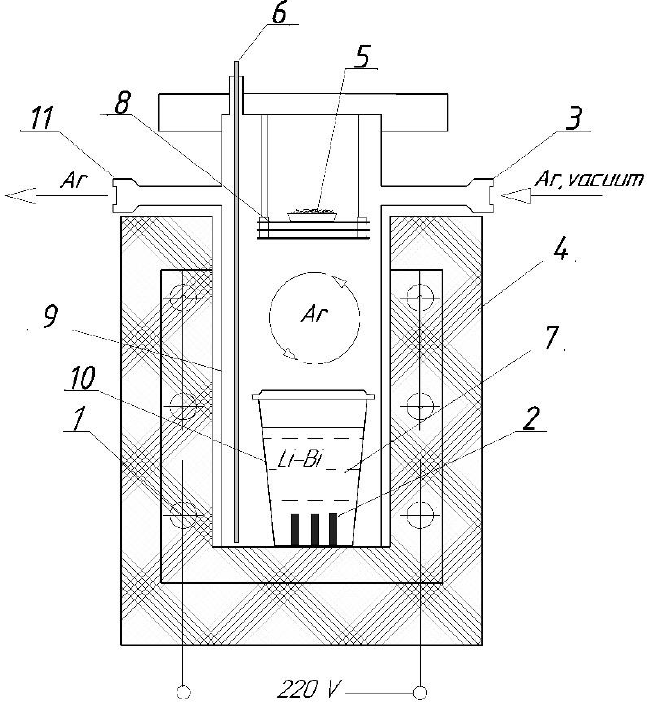
Figure 1. Experimental setup for corrosion experiments: heaters ( 1 ); test sample ( 2 ); gas inlet ( 3 ); furnace ( 4 ); titanium getter ( 5 ); thermocouple ( 6 ); liquid metal ( 7 ); nickel heat-reflecting screens ( 8 ); steel cell ( 9 ); crucible ( 10 ); gas outlet ( 11 ). Each cell was sealed, evacuated, filled with argon, and placed in a vertical tube fur- nace. A flow of high-purity argon (99.999%) through the cell was maintained for the du-